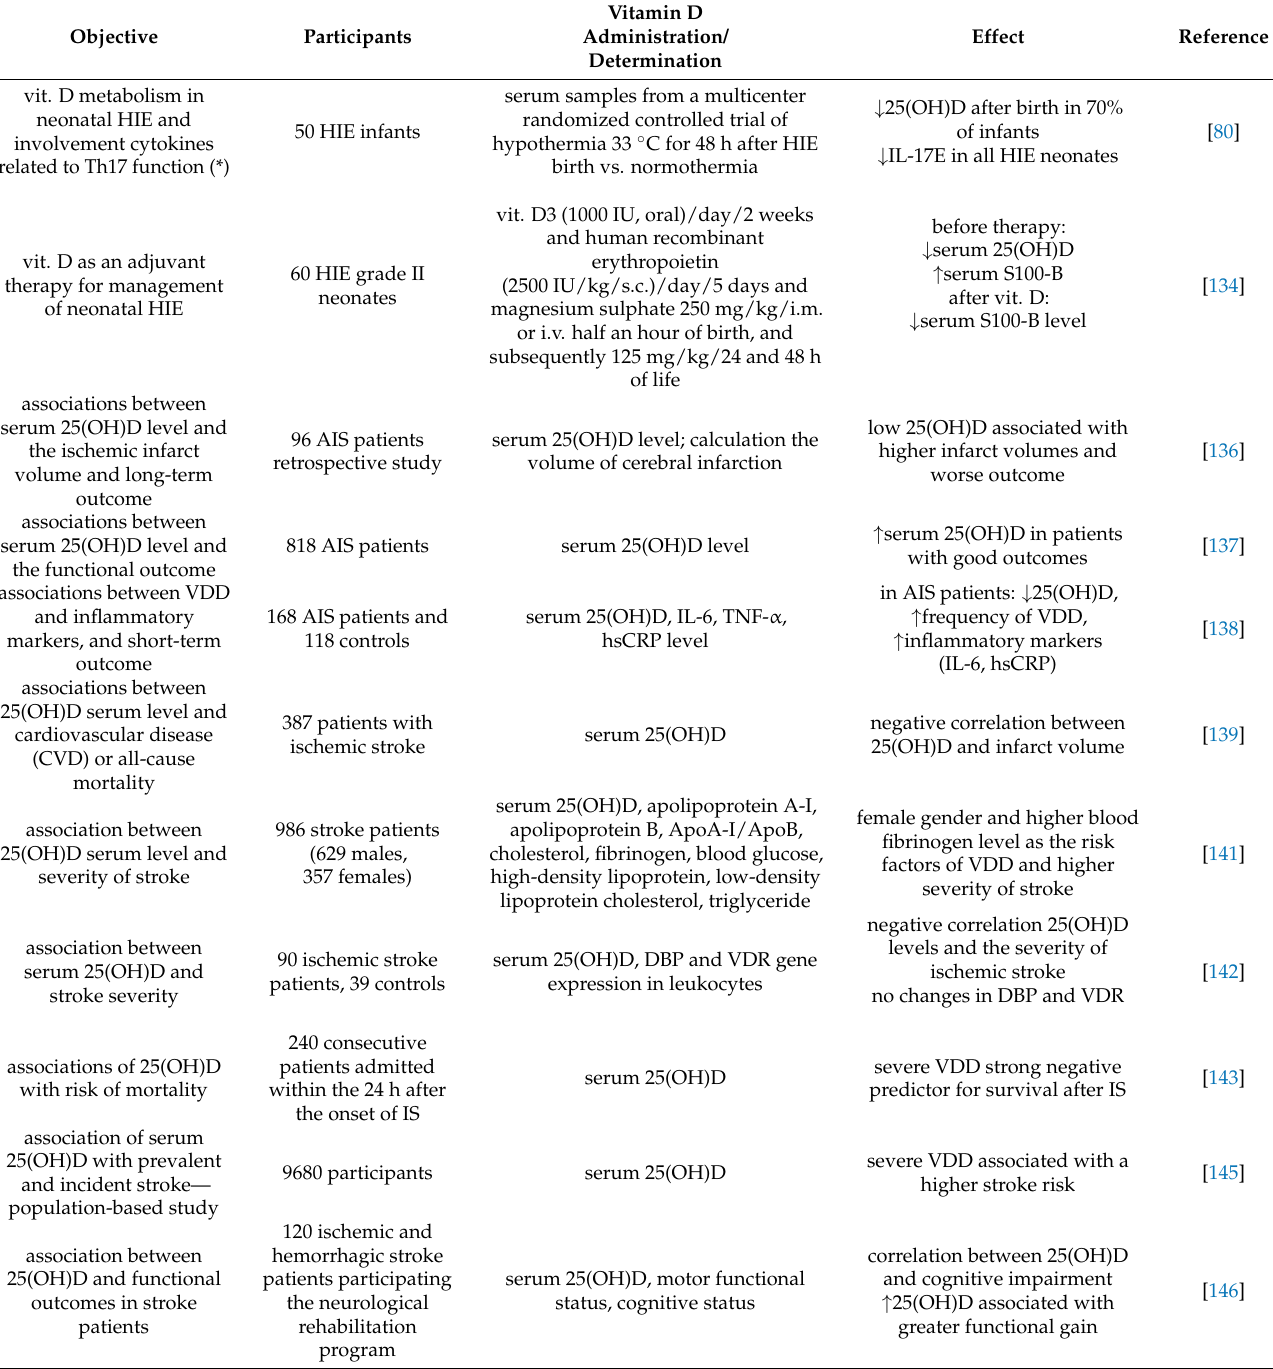
Table 3. Effects of vitamin D in patients with stroke—supplementation/blood level/clinic symp- toms/treatment/healthy control—clinical